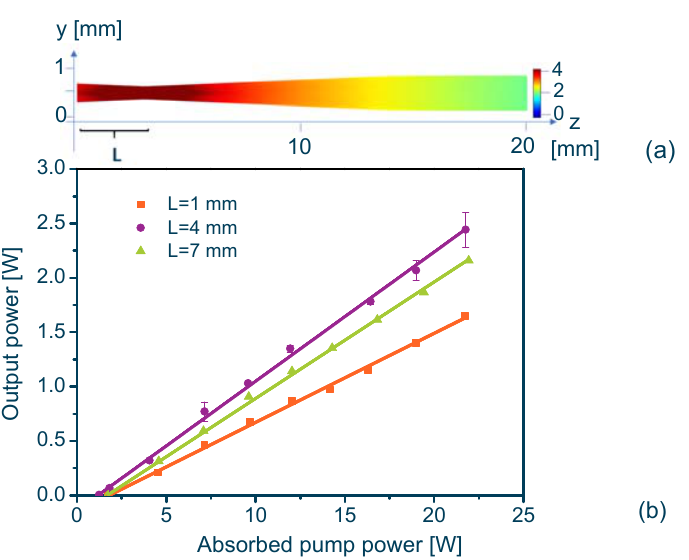
Figure 3. Simulated pump intensity distribution in the SCF by using ray tracing analysis ( a ), and output power of Tm:LuAG SCF for the focal points at different positions ( b ), L: distance between the input end facet and focal point.